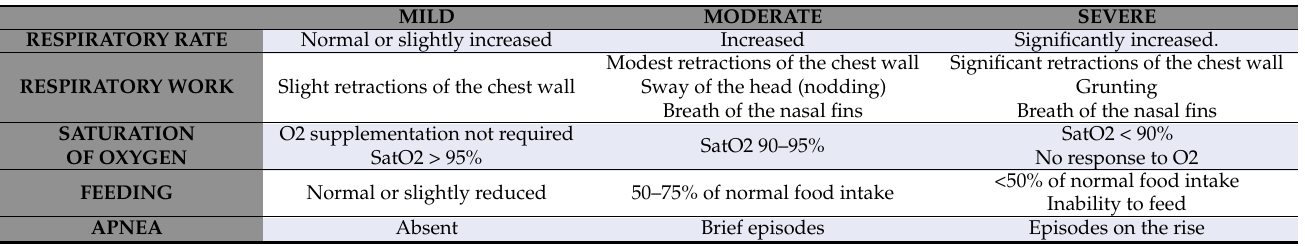
Table 1. Clinical criteria used to classify bronchiolitis according to Consensus Baraldi et al. (modified). The presence of two or more criteria from each category listed in the table attribute bronchiolitis to that severity